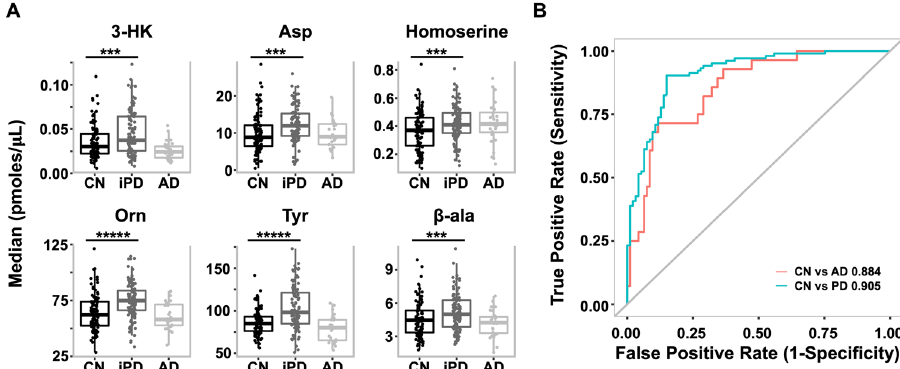
Fig. 1 Elevation of six metabolites in iPD serum. A Box plot of top six biomarker iPD vs CN and AD (median values in picomoles/µl serum, data taken from Table 1). *** indicates a p value of <0.001 and ***** of <0.00001. B Multivariate ROC analyses resulted in a linear model being able to separate iPD from CN and AD from CN. In the case of iPD vs CN, a panel of seven metabolites resulted in an AUC value of 0.905. For further details, see Table